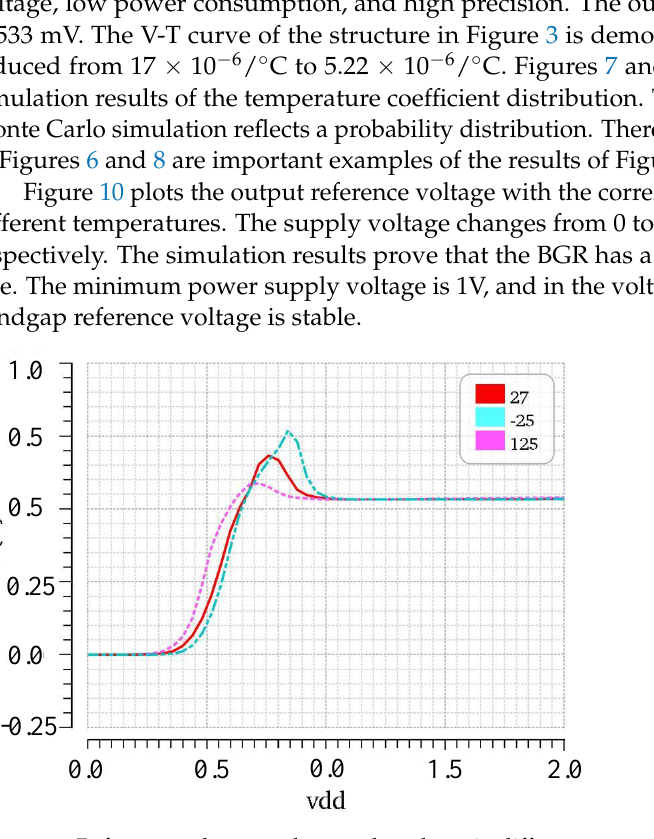
Figure 9. In reference 2 ( a ) 200 Monte Carlo simulation results for TC after first-order temperature compensation; ( b ) 200 Monte Carlo simulation results for TC after high-order temperature compensation.